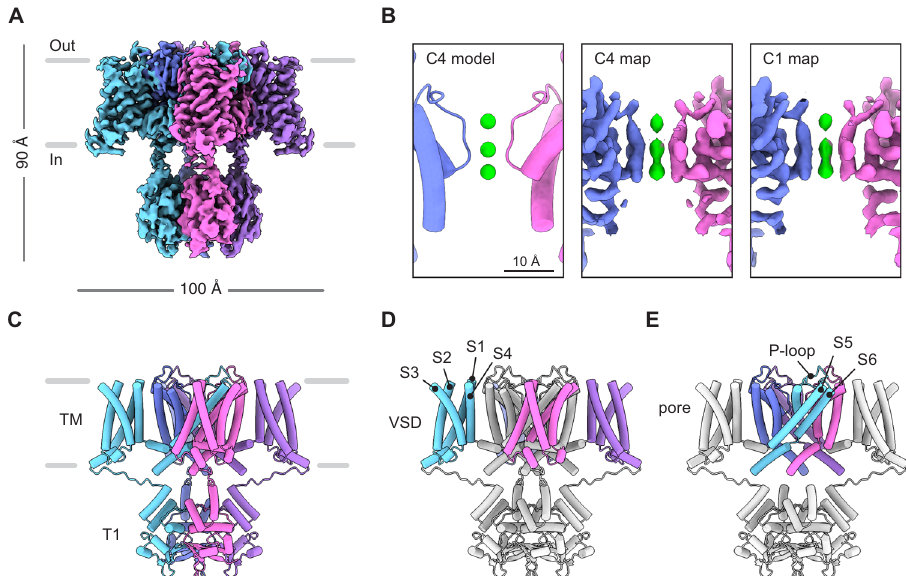
Fig. 1 Structure of human Kv1.3. A Cryo-EM density map of human Kv1.3. B The pore region of Kv1.3 as modeled with C4 symmetry (left), as seen in the density map re fi ned with C4 symmetry (middle) or as modeled with C1 symmetry (right). This panel highlights the presence of three K + ion densities and the equivalent ion occupancy when using C1 and C4 symmetries. K + ions shown in green. C Model of human Kv1.3 with C4 symmetry constraints. The transmembrane (TM) region and T1 domains are indicated. Model of Kv1.3 with the voltage sensing domains (VSDs) colored ( D ), or with the pore domain colored ( E ). The front and rear VSDs are omitted for clarity in E